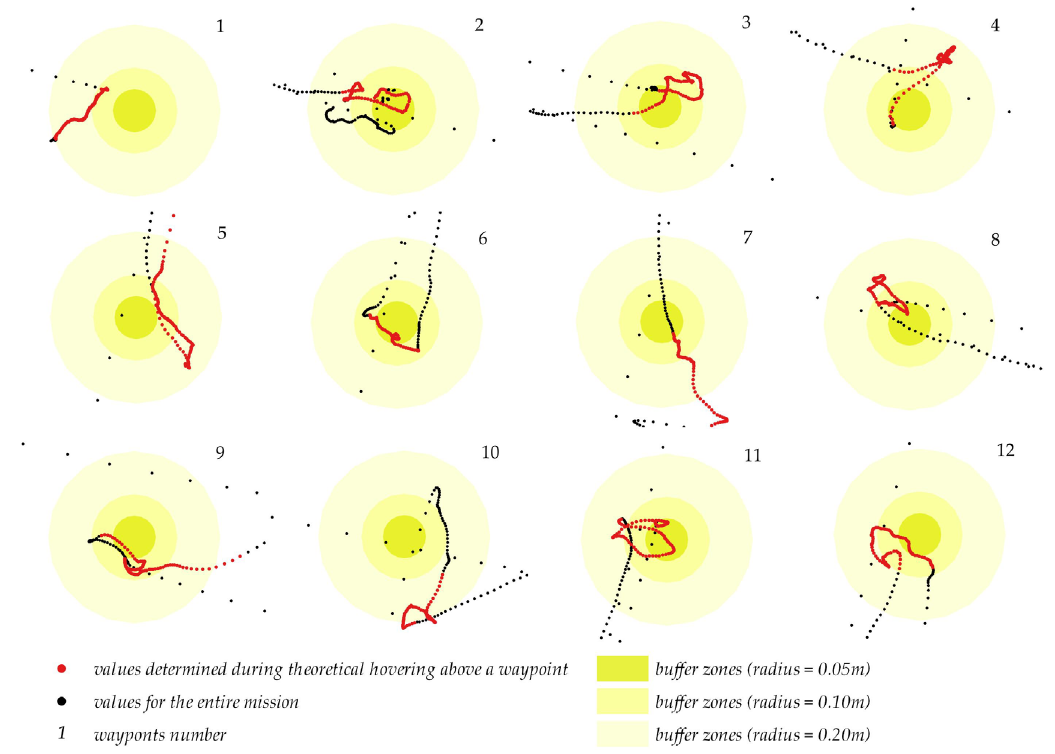
Figure 11. Standard deviation for every observed